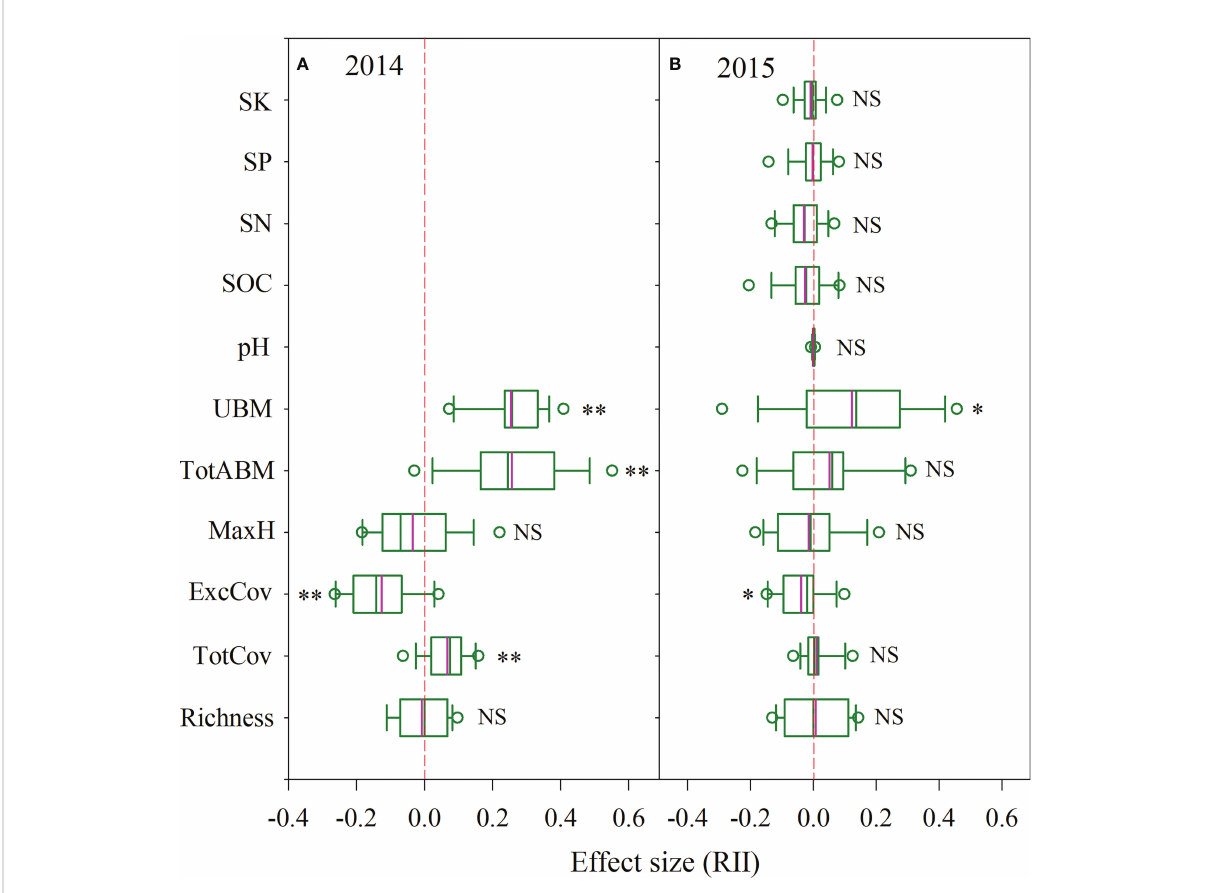
FIGURE 2 The effect size of P. kansuensis invasion on native community structure and soil environment by the fi eld experiment of P. kansuensis removal [ (A) 2014yr; (B) 2015yr]. The pink line in the box diagram is the mean. Signi fi cant differences are reported from Mixed Linear Model as NS, P ≥ 0.05; *P < 0.05; **P < 0.01. Key: TotABM, Total aboveground biomass of the sample plots; UBM, total underground biomass of the sample plots; pH, soil pH. For other abbreviations refer to the note in Figure